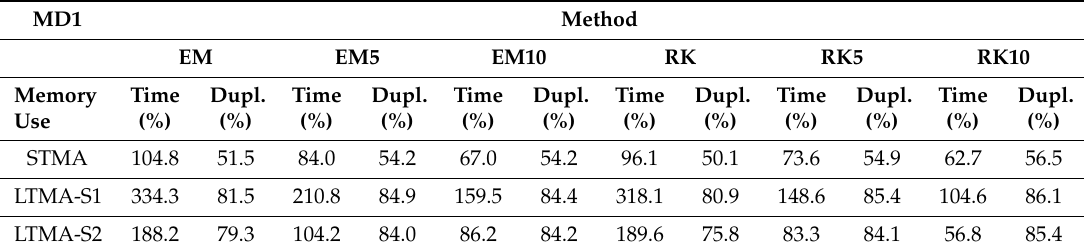
Table 30. Mean value of the calculation Times (Time) and Duplications (Dupl.) in respect to no